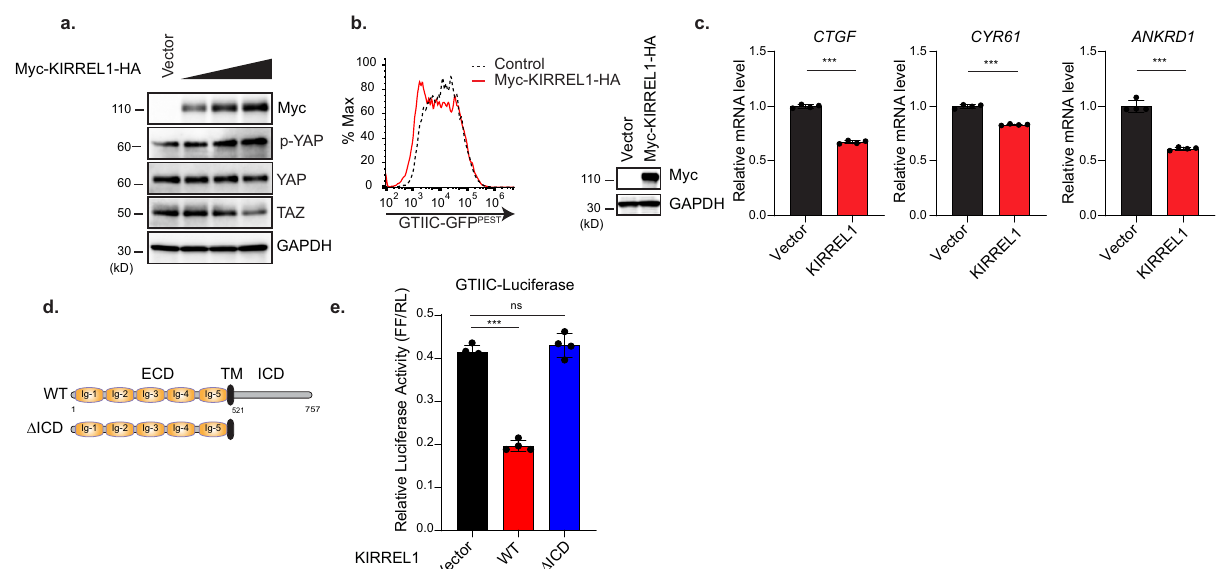
Fig. 2 Overexpression of KIRREL1 enhances Hippo signaling in HEK293A cells. a Overexpression of KIRREL1 decreases the expression of TAZ protein and increases YAP phosphorylation. HEK293A cells were transfected with increasing amount of Myc-KIRREL1-HA construct and seeded at medium density (0.5 × 10 6 cells/well) in 12-well plate 24 h of post-transfection. Cells were harvested the next day and analyzed by western blot. b Left panel, overexpression of wild-type KIRREL1 decreases YAP-mediated GTIIC-GFP reporter activity in HEK293A GTIIC-GFP PEST Cas9 cells. Right panel, western blot showing KIRREL1 expression. c Overexpression of wild-type KIRREL1 decreases YAP target gene expression. The data represent mean ± SD, n = 4, error bars denote the SD between four biological replicates; Unpaired two-tailed t -test was used to determine the statistical signi fi cance, *** p value < 0.001. d Schematic of wild-type (WT) and Δ ICD mutant of KIRREL1. e Overexpression of KIRREL1 inhibits YAP-responsive GTIIC-luciferase reporter activity. HEK293A cells were co-transfected with YAP and indicated constructs along with GTIIC-luciferase, and TK- Renilla luciferase, and subjected to dual luciferase assay. The data represent mean ± SD, n = 4, error bars denote the SD between four biological replicates; Unpaired two-tailed t - test was used to determine the statistical signi fi cance biological replicates, *** p value < 0.001, ns — 0.3886. Source data for Fig. 2a – c, e are provided as Source Data fi interaction between the puri fi ed KIRREL1 ICD and MST1 (Fig. 3e — right panel), indicating the speci fi city of KIRREL1 ICD-SAV1 interaction. In addition, we performed a Ni-NTA pull-down assay by mixing the recombinant ICD 77 C-ter or ICD 80 N-ter of KIRREL1 ICD and puri fi ed Flag-tagged SAV1. ICD 77 C-ter, but not ICD 80 N-ter, pulled down puri fi ed SAV1 (Fig. 3f), suggesting that the C-terminal end of the KIRREL1 ICD directly binds to SAV1. To test whether the C-terminal region of the KIRREL1 ICD is essential for inhibiting YAP activity, we performed a GTIIC-luciferase assay in HEK293A cells. As expected, while overexpression of wild-type (WT) KIRREL1 and the ICD Δ 1 mutant inhibited YAP-mediated GTIIC- luciferase reporter activity, deletion of the C-terminal end of the KIRREL1 ICD (ICD Δ 3) abrogated this inhibitory effect (Fig. 3g and Fig. S3b). Consistently, overexpression of WT and ICD Δ 1, but not ICD Δ 3, reduced YAP target gene expression (Fig. S3c) and decreased expression of endogenous TAZ protein (Fig. S3d).